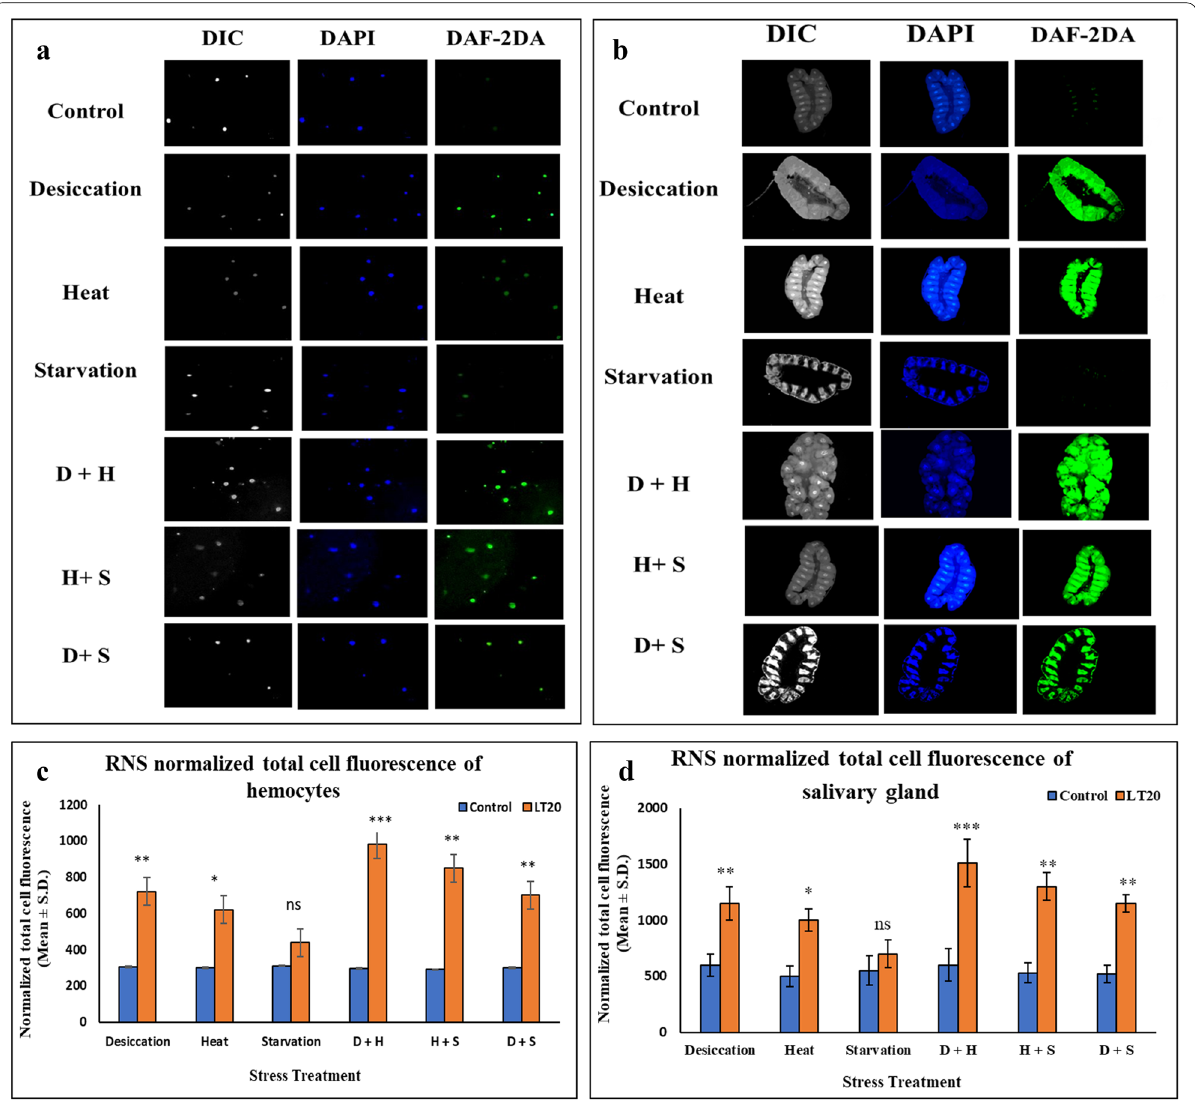
Fig. 5 Cellular level visualization of reactive nitrogen species (RNS): Fluorescence microscopic images of fluorescent dye 4,5-diaminofluorescein diacetate (DAF-2DA), 4 ′ ,6-diamidino-2-phenylindole (DAPI) and differential interference contrast (DIC) of hemocytes and salivary glands of C. ramosus exposed to desiccation, heat, starvation, D H, H S, D S stress treatments compared against control a hemocytes magnification (400X) + + + b salivary gland (100X) to visualize reactive nitrogen species. Normalized cell fluorescence intensity of c hemocytes d salivary gland of C. ramosus to quantify reactive nitrogen species. ***P < 0.001; **P < 0.01; *P < 0.05 indicates significance